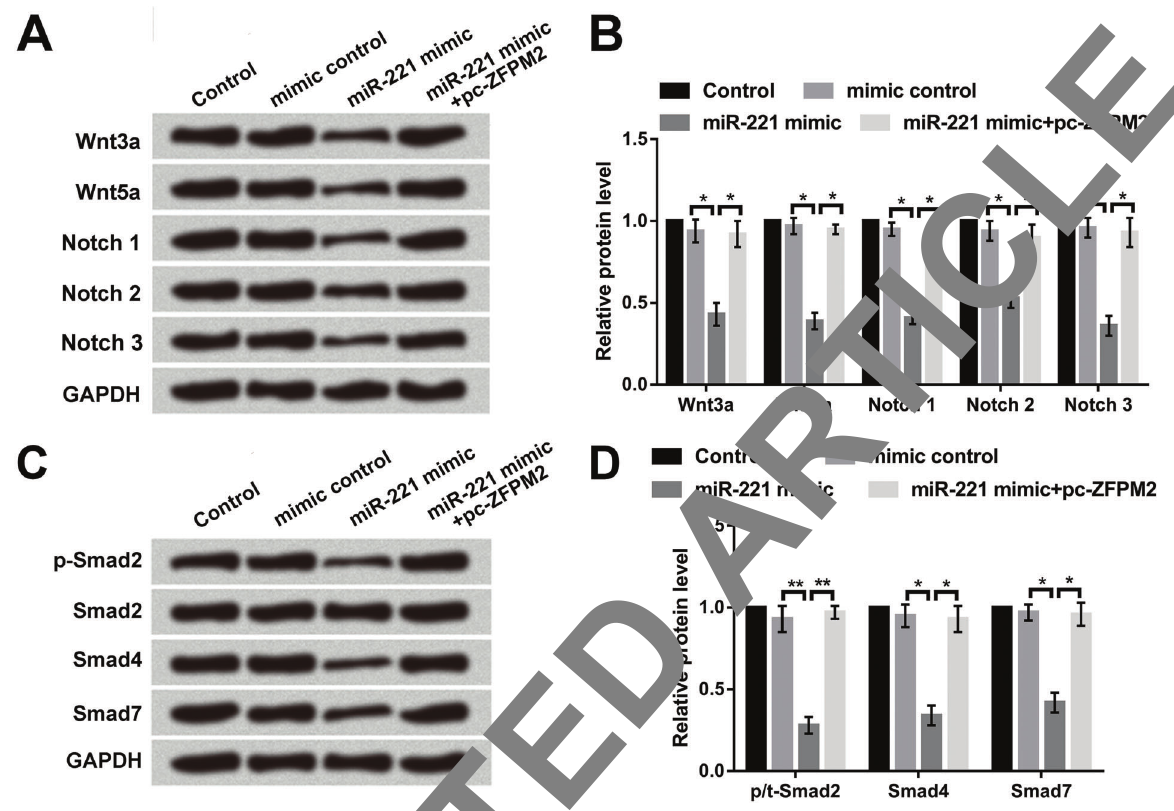
Figure 7. Overexpression of miR-221 deactivated Wnt/Notch and Smad signaling pathways. MC3T3-E1 cells were transfected with mimic control, miR-221 mimic, or miR-221mimic + pc-ZFPM2. The protein levels of ( A and B ) Wnt3a, Wnt5a, Notch 1, Notch 2, and Notch 3, and ( C and D ) Smad2, Smad4, and Smad7 were determined using western blot. miR-221: microRNA-221; zFPM2: Zinc fi nger protein multitype 2. Data are reported as means ± SD. *P o 0.05, **P o 0.01